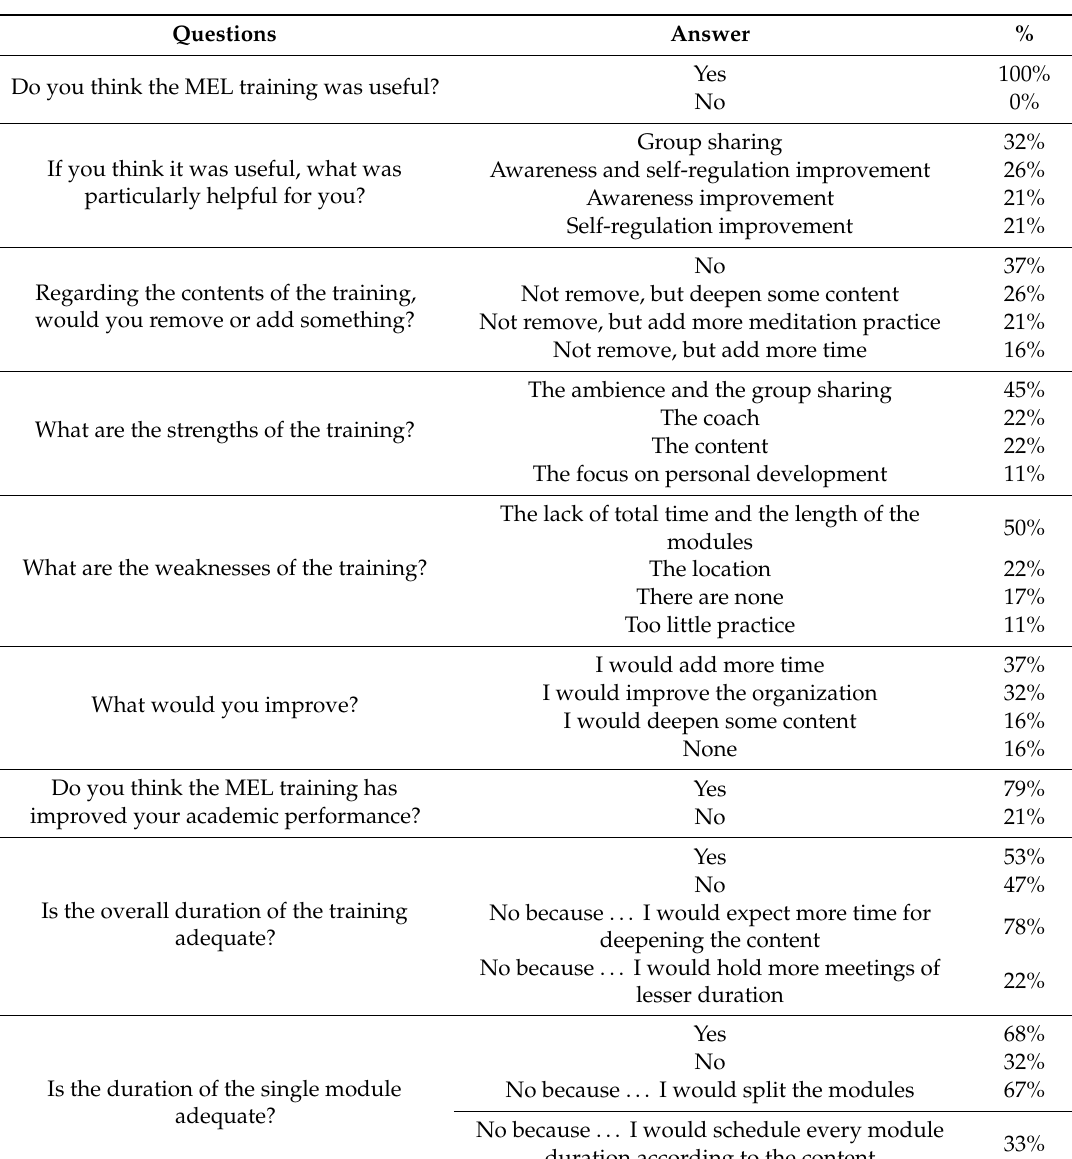
Table 8. Follow-up self-report